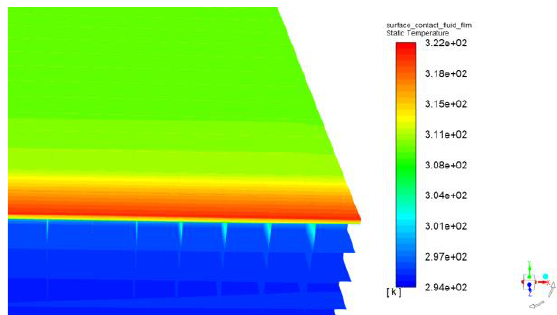
Fig. 12. Isometric view of a temperature distribution in the fluid up to contact surface with heating film, drawn on mesh